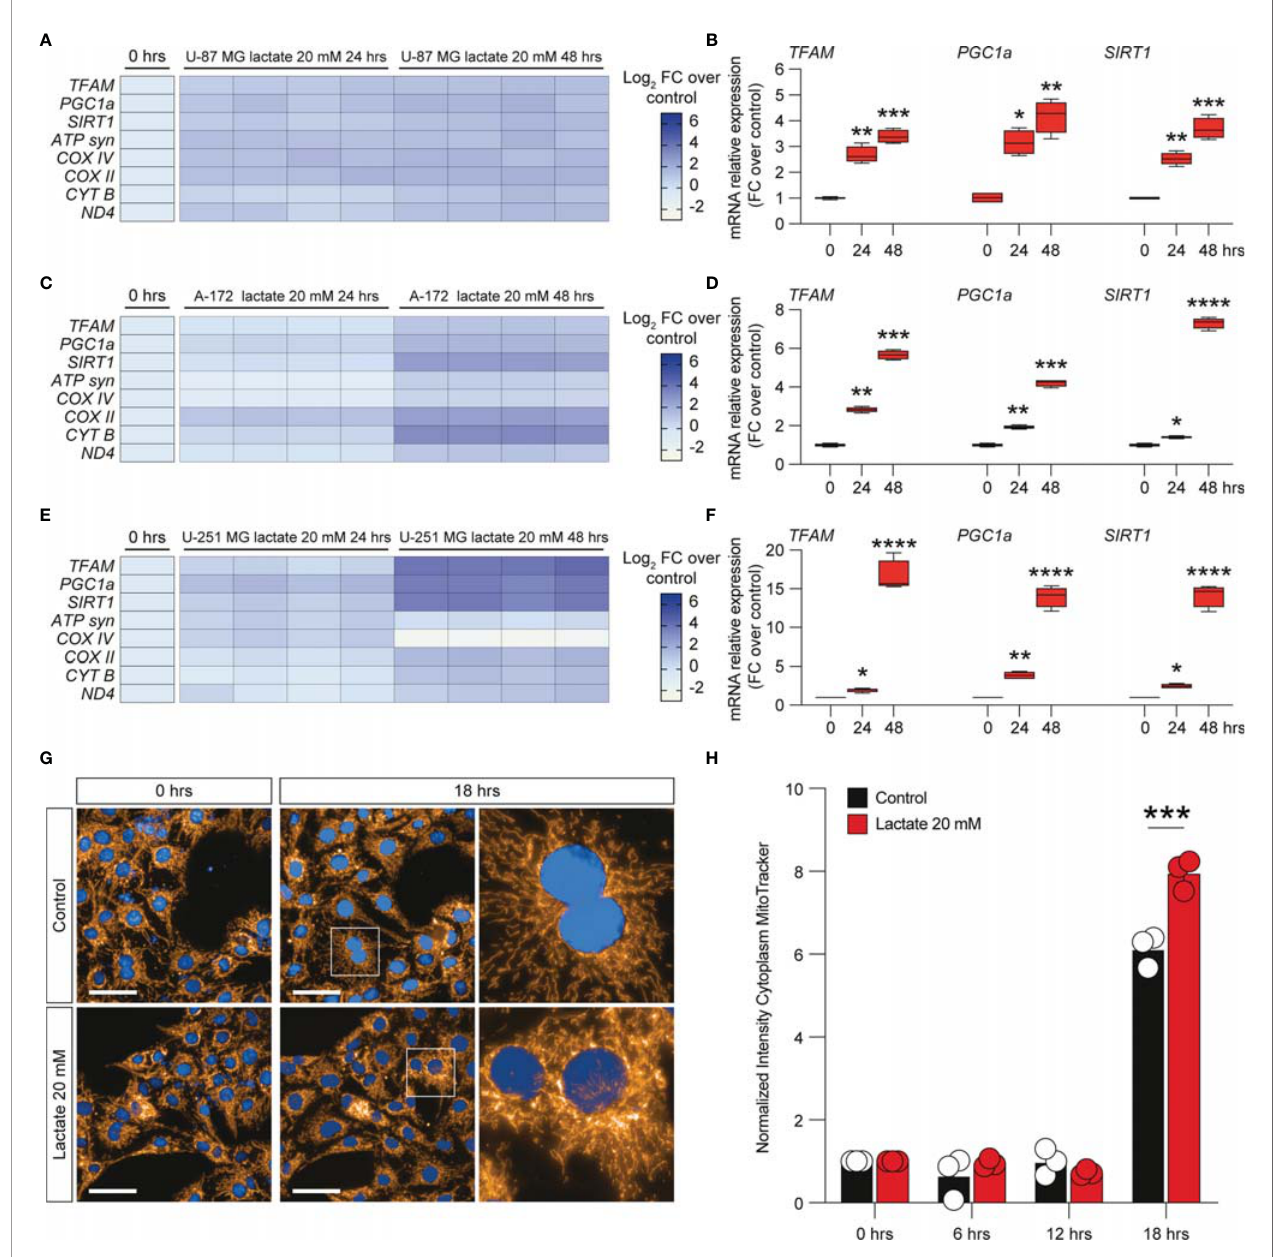
FIGURE 4 | Lactate promoted the upregulation of mitochondrial activity gene expressions in glioblastoma cells. (A – F) Effect of lactate (20 mM) on mitochondrial biogenesis and OXPHOS gene expression in U-87 MG cells (A, B) , A-172 cells (C, D) , and U-251 MG cells (E, F) following 24 and 48 h of treatment. (G, H) Computerized analysis of the MitoTracker fl uorescence intensity in the control versus lactate 18 h after treatment. The fi gures presented are representative of at least three independent experiments. Values represent the mean ± SEM of experiments performed in quadruplicate. P -values <0.05 were considered as statistically signi fi cant (* p < 0.05; ** p < 0.01; *** p < 0.001 ; ****p < 0.0001 vs .